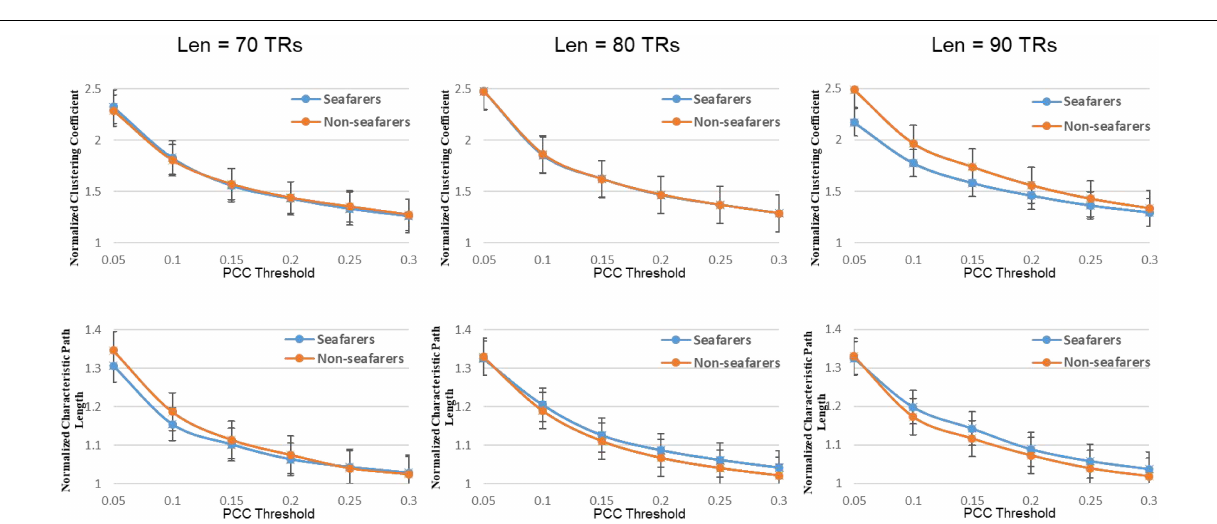
have used linear correlations between brain regions to construct and interpret brain networks, like PCC. However, the PCC and linear correlation are only sensitive to the linear component and may ignore the non-linear relationship between brain